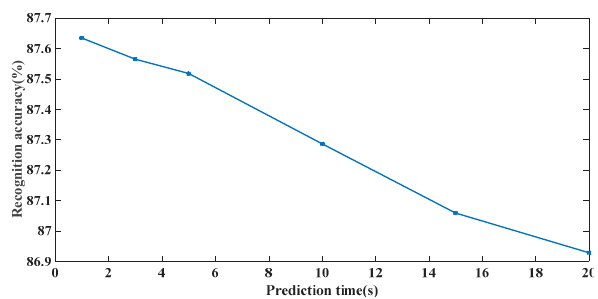
Figure 11. The relation between prediction period and recognition accuracy.